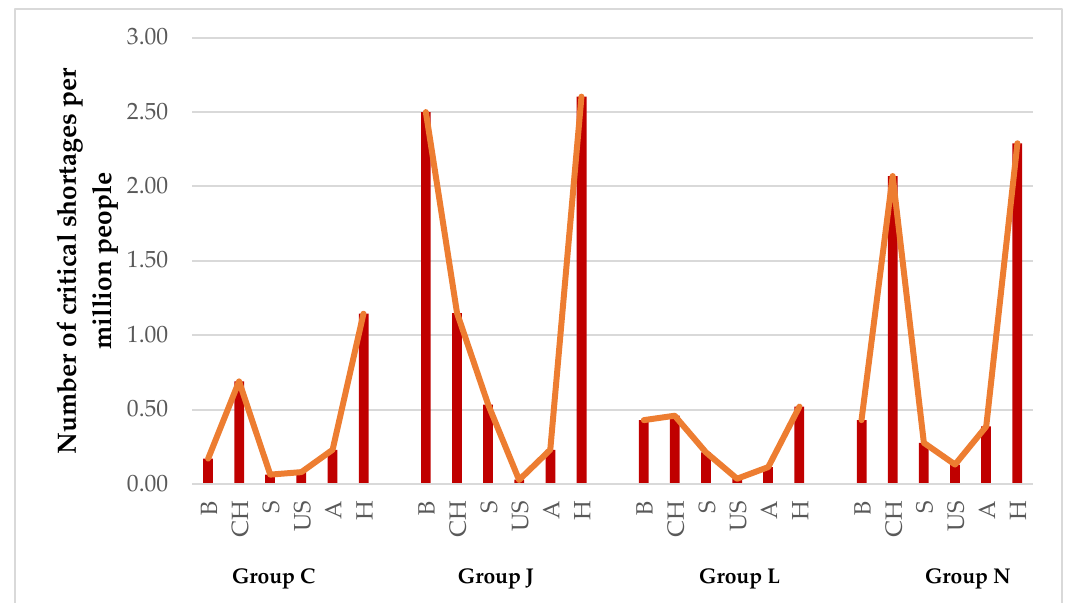
Figure 2. Comparison of critical shortages of various countries by ATC groups.